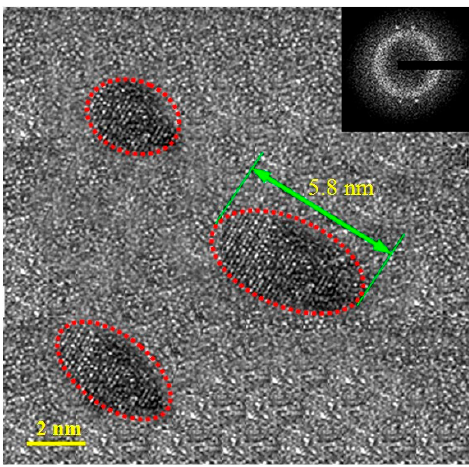
Figure 8. The bright field image and selected area diffraction pattern of the 3# weld. from the right side, and R or L + 5 mm and L + 3 mm have similar implications. The mean